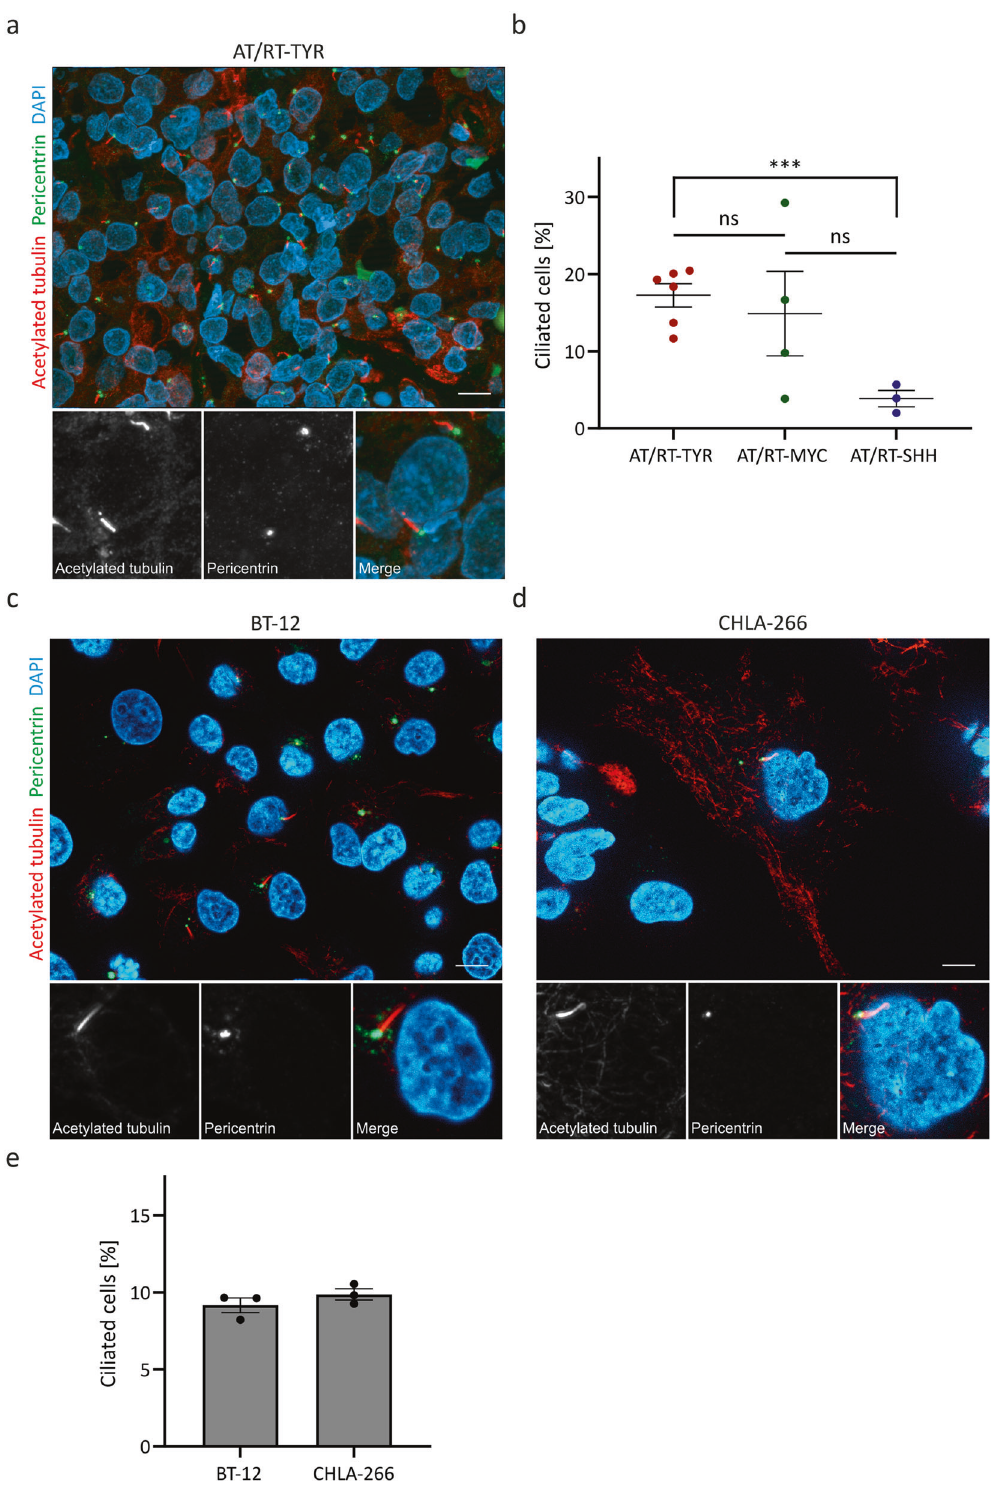
Fig. 1 Detection of primary cilia in AT/RT tumor tissue sections and cell lines. Tumor tissue sections of AT/RT patients were deparaf fi ned and stained for pericentrin (green) and acetylated tubulin (red) to detect the basal body and the axoneme of the primary cilium, respectively. Nuclei were counterstained with 4´,6 ‐ diamidino ‐ 2 ‐ phenylindole (DAPI, blue). Overall, a total of 13 different AT/RT tumor tissue samples were examined, including six AT/RT ‐ TYR, four AT/RT ‐ MYC and three AT/RT ‐ SHH tumors. A representative immuno fl uorescence image for an AT/RT ‐ TYR tumor is shown in ( a ). b Quanti fi cation of the percentage of ciliated cells in each of the AT/RT tumor tissue samples revealed a signi fi cant difference across tumor subgroups. AT/RT cell lines BT ‐ 12 ( c ) and CHLA ‐ 266 ( d ) were fi xed and stained using the same immuno fl uorescence protocol used for the AT/RT tumor tissue samples. Quanti fi cation of the percentage of ciliated cells in BT-12 and CHLA-266 cells is shown in ( e ). ns: not signi fi cant; *** p < 0.001 ( t -test). The scale bar corresponds to 10 μ m.